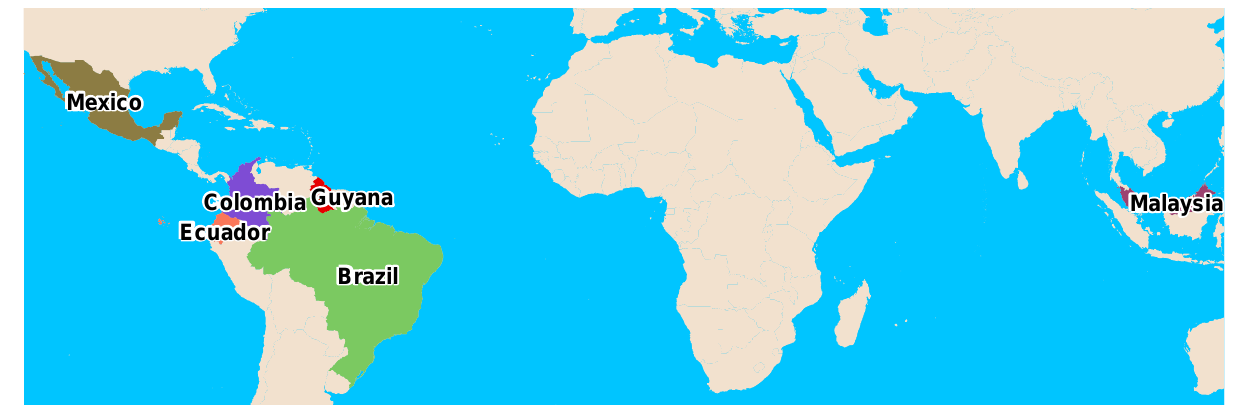
Figure 1. Countries that have submitted proposed FRELs to the UNFCCC, as of Dec.